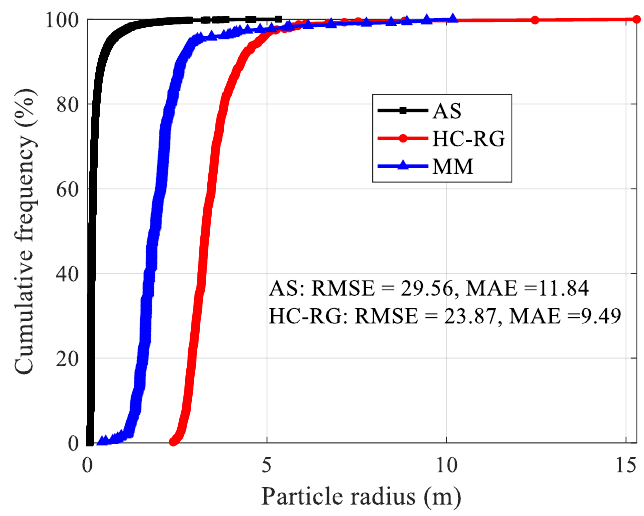
Figure 15. Particle radius distribution of upper accumulation of landslide.